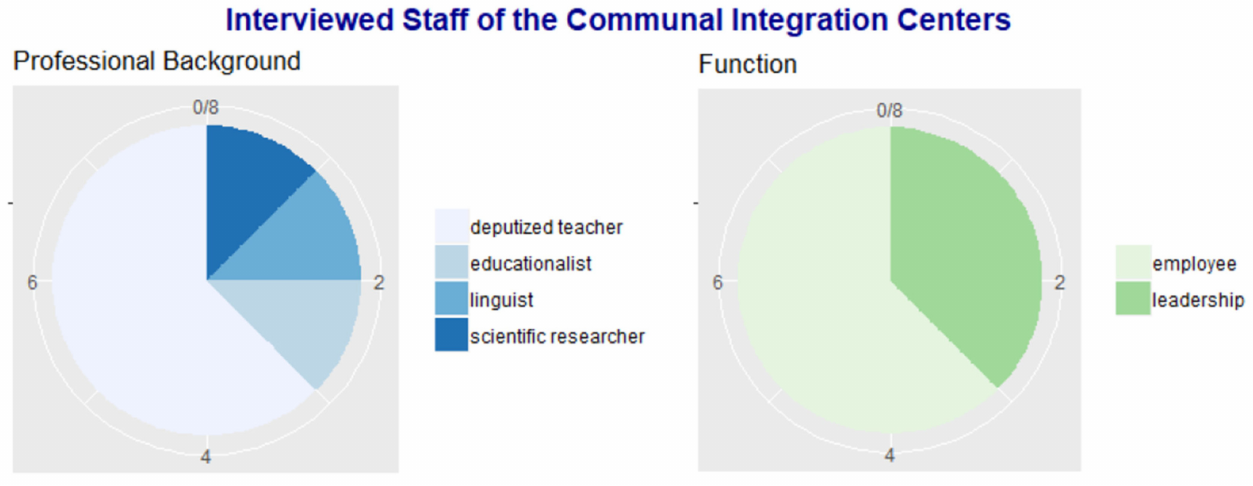
Figure 2. Information on the interviewed staff of the CICs.